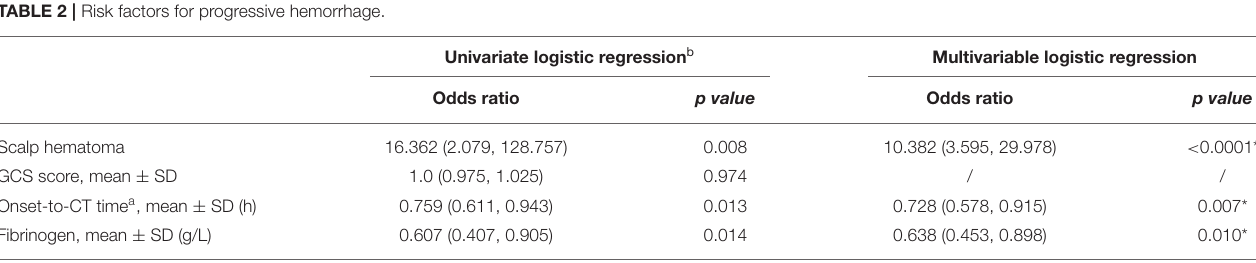
TABLE 2 | Risk factors for progressive